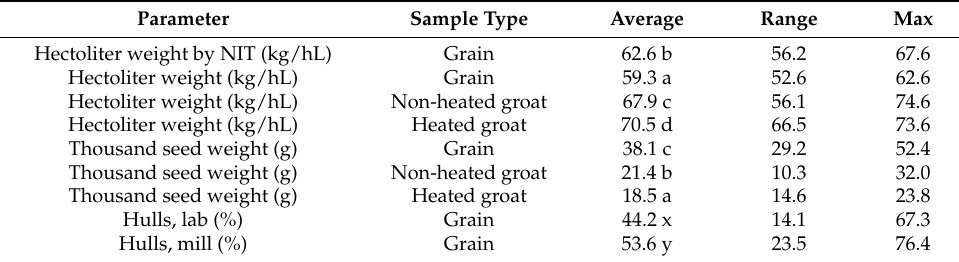
Different letters (a, b, c, d) within each column and parameter indicate statistically significant differences ( p < 0.05) between the samples based on Tukey’s HSD test. Different letters, x and y, within each column and component indicate a statistically significant difference ( p < 0.05) between the samples based on an independent sample t -test. The color values, L* and b*, of the native oat grains were higher, and the a* values were lower compared to the L*, a* and b* values of the non-heated groat samples (Table 2). The milling process affected the color properties of the oat groats, as the L*, a* and b* values of the heated oat groat samples were significantly ( p < 0.05) different from the color properties higher L* and b* values, and lower a* values on average. The color properties of the